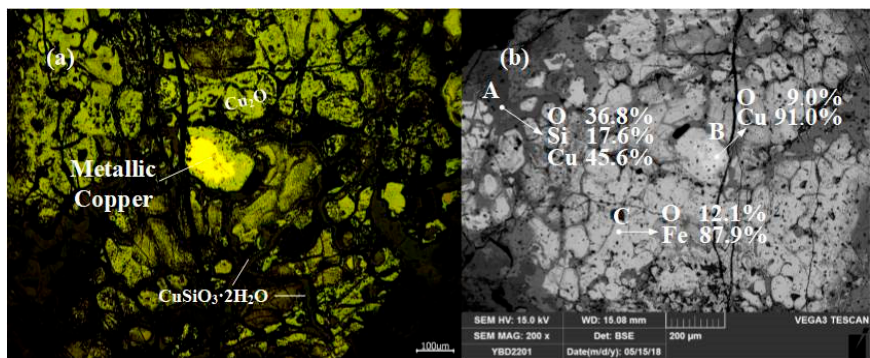
microscopy enveloped by oxidized copper ore. As shown in Figure 26.